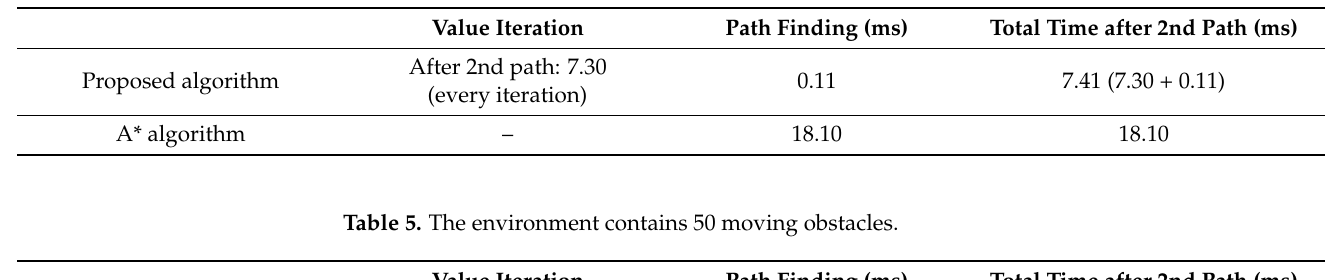
Table 4. The environment contains 10 moving obstacles.